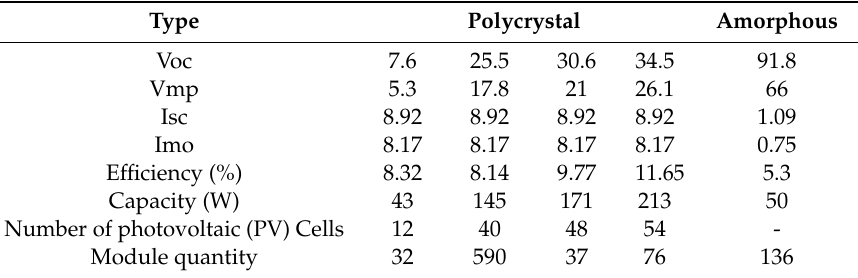
Table 2. Performance overview of the installed modules.